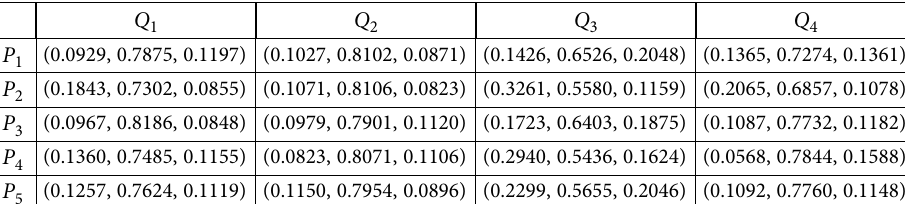
Table 6. The weighted normalized assessing matrix